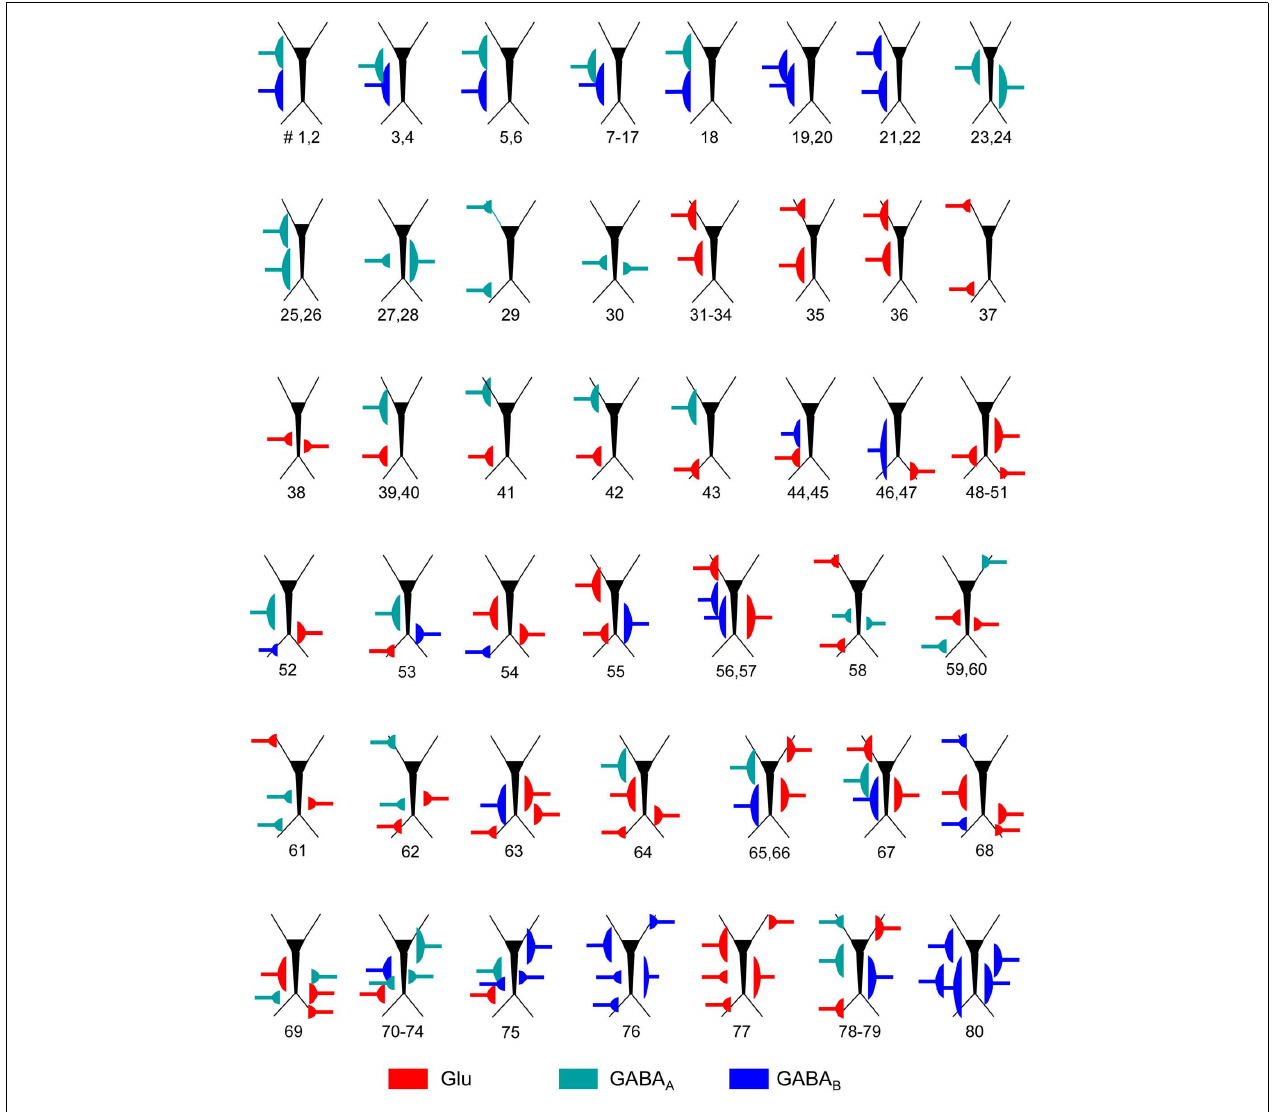
populations.The relative position of inputs along the somato-dendritic axis over the dummy neuron is scaled with the prototype CA1 pyramidal model cell.The numbers below indicate the different simulations for the particular synaptic input